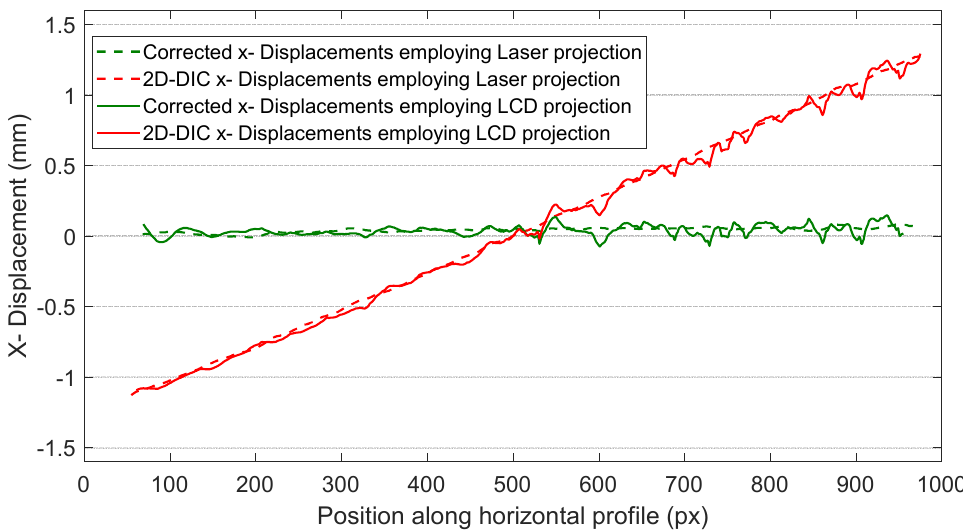
Figure 14 . Δ x displacents meaured with 2D-DIC (red) and 2D-DIC corrected with fringe projection (FP) (green) along the red dashed profile in Figure 13.